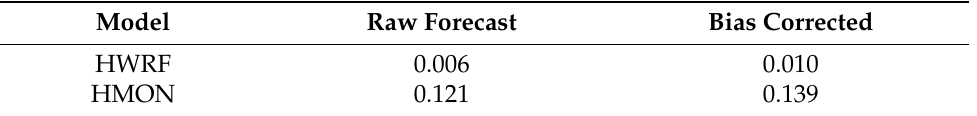
Table 3. Brier Skill Score of the Probability of RI based on 2017–2019 HWRF and HMON ensemble data during each 24 h period from 0 to 24 h to 48–72 h. The bias corrected forecasts use the quantile- mapping method, while the raw forecasts do not use any bias correction. For this calculation, the climatological frequency is assumed to be